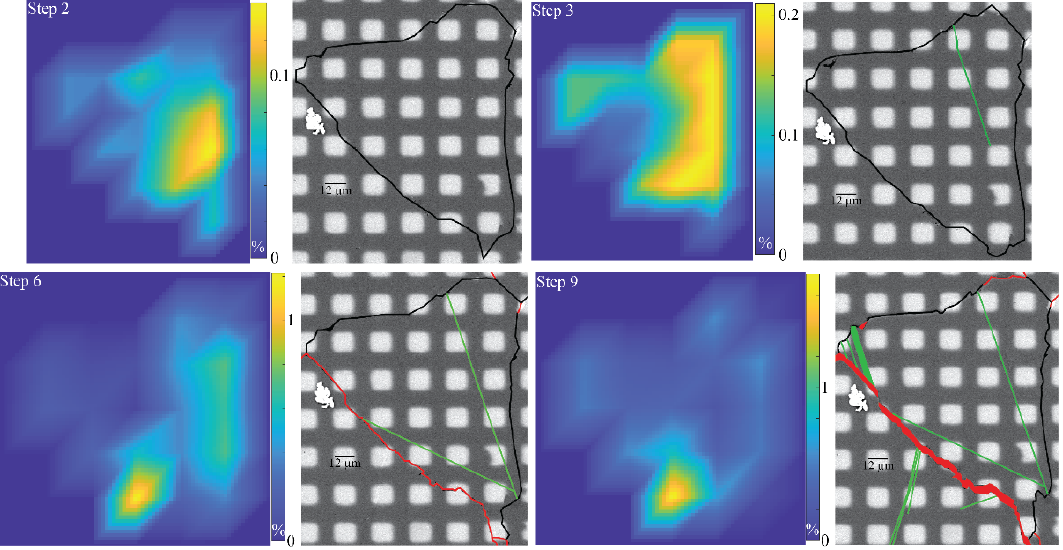
Figure 23. Von Mises deformation map of crystal 17 at different steps of sample deformation. The black lines represent the grain boundaries. The green lines show the twinned planes. The red lines show the fracture zones.